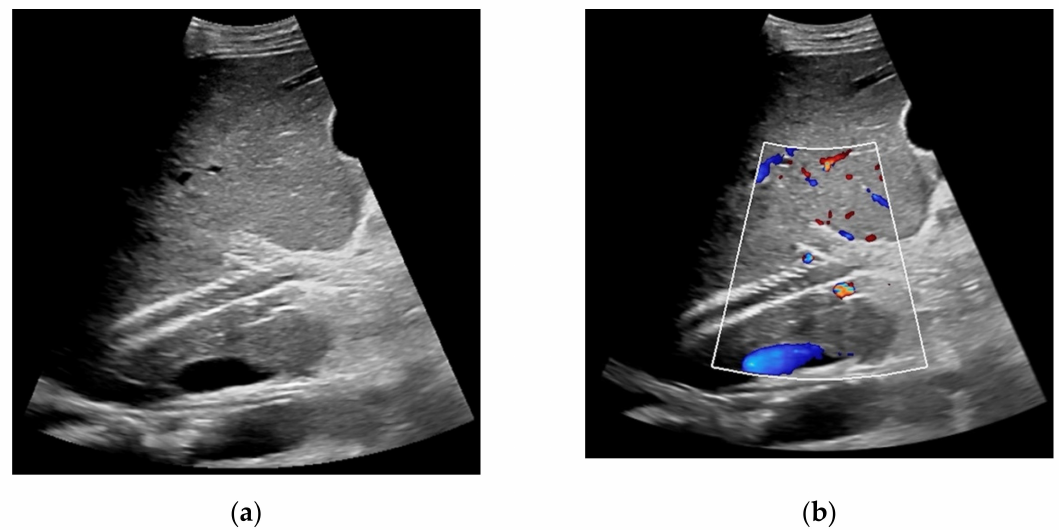
Figure 2. 57-year-old female patient with occluded transjugular intrahepatic portosystemic shunt in B-mode ( a ) and consecutive absent flow signal in Color Doppler ultrasound ( b